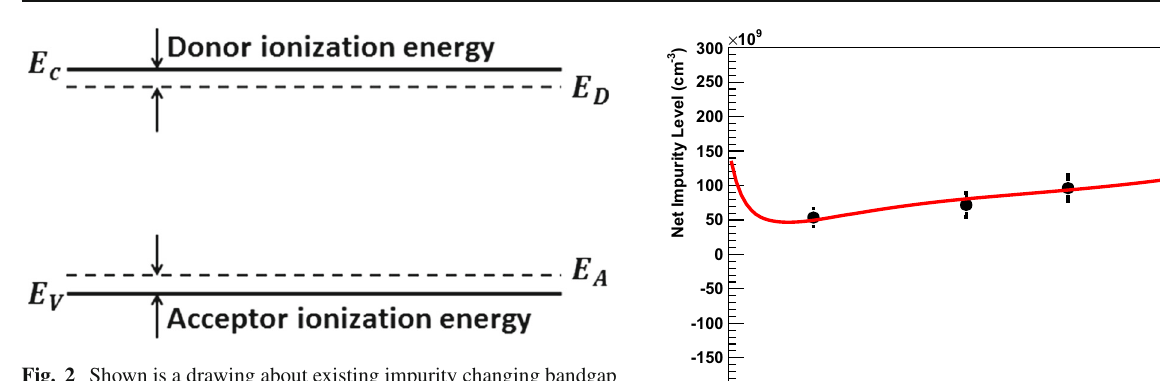
Fig. 2 Shown is a drawing about existing impurity changing bandgap energy. Where E C stands for the minimum energy of conduction band; E D refers to the energy of valance of donors; E A is the energy of conduction of acceptors; and E V is the maximum energy of valance band.Thus,( E C − E D )istheionizationenergyofdonorsand( E A − E V ) is the ionization energy of acceptors